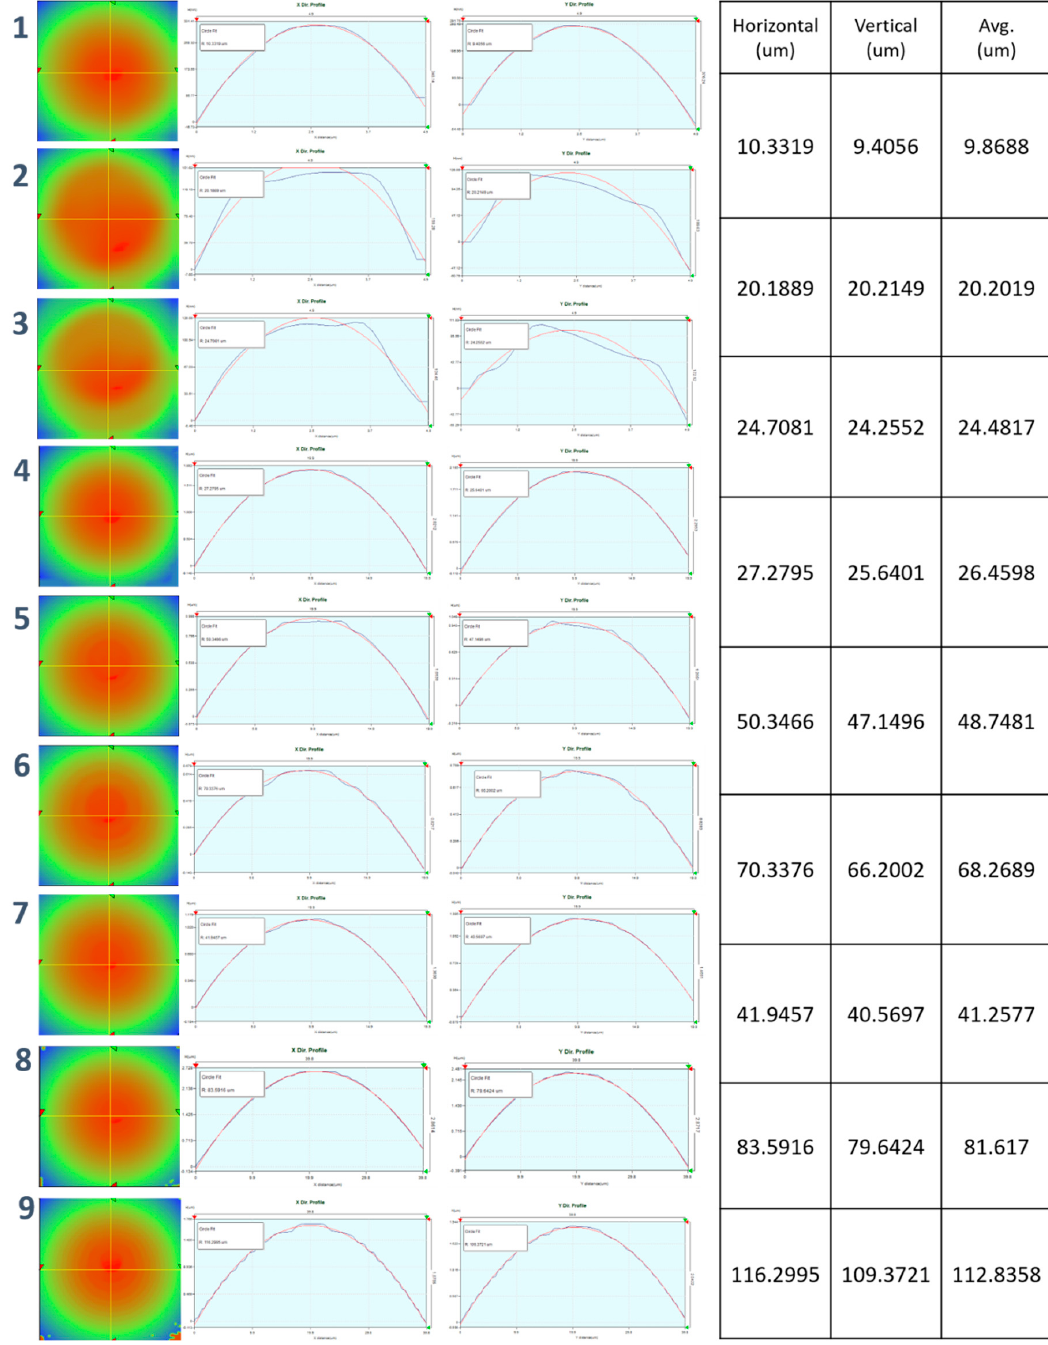
Figure A13. ROC measurement data for 2nd single-mold replica (stamp).